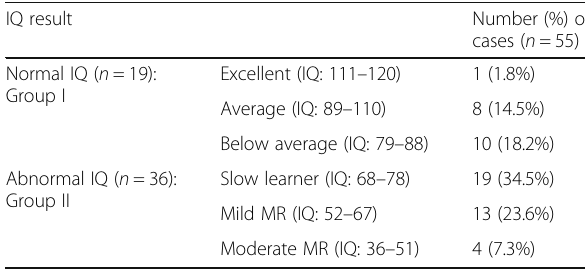
Table 3 Distribution of the studied cases according to